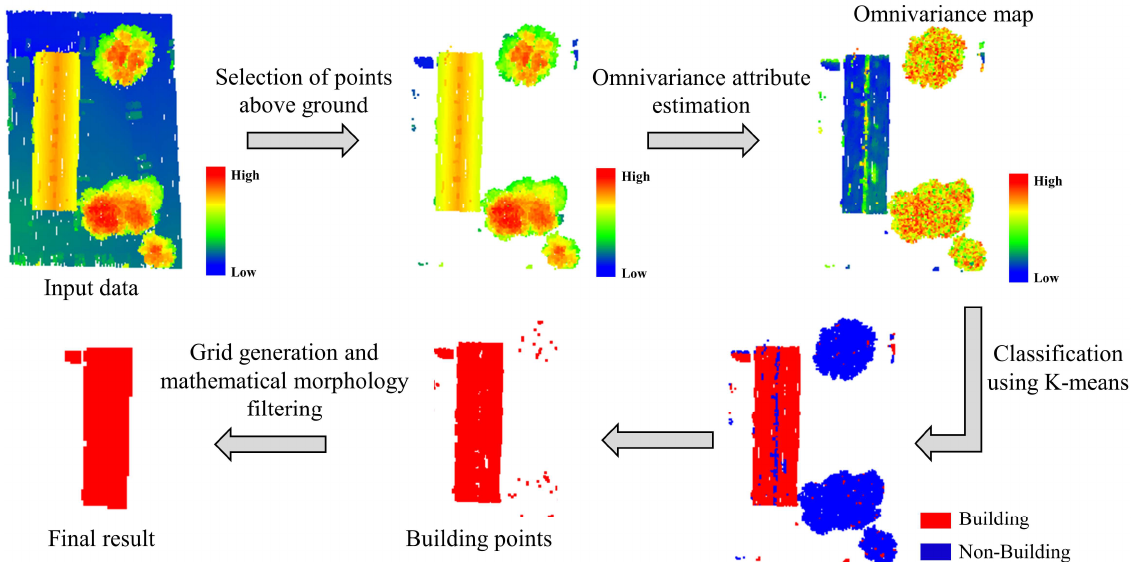
Figure 1. Proposed method for building